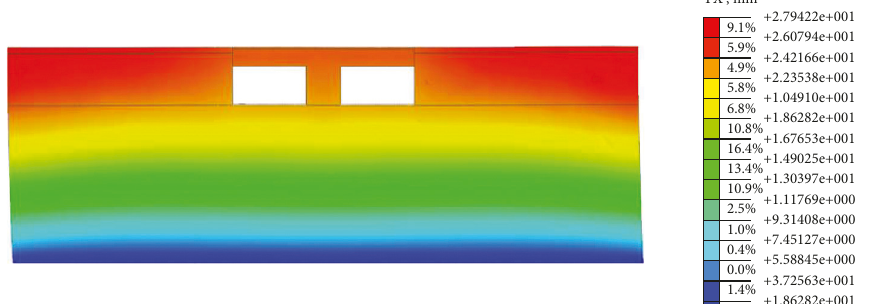
Figure 11: Transverse relative displacement of the stratum.